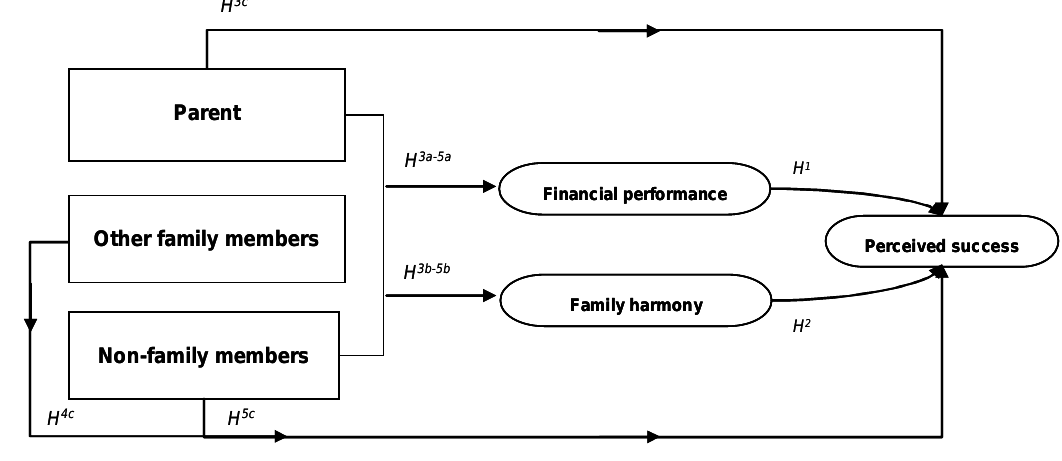
Figure 1 Family and non-family members influencing the Perceived success of Sibling